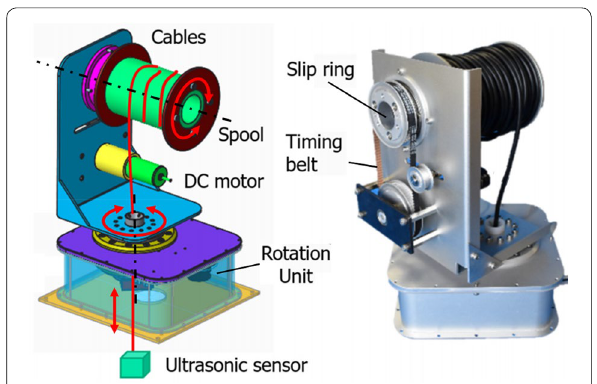
Fig. 4 Prototype model of the winch mechanism with two DoFs (left: 3DCAD model, right: hardware